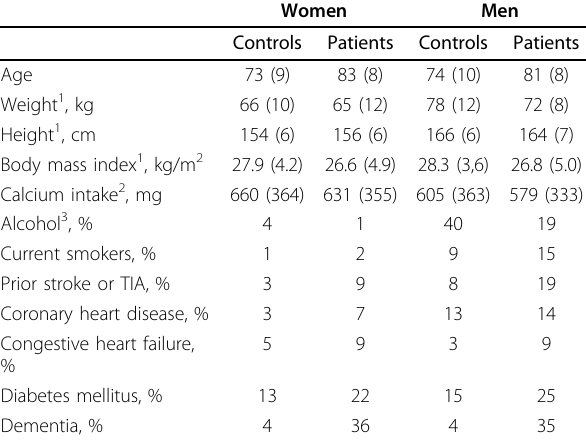
Table 1 Clinical characteristics of patients and